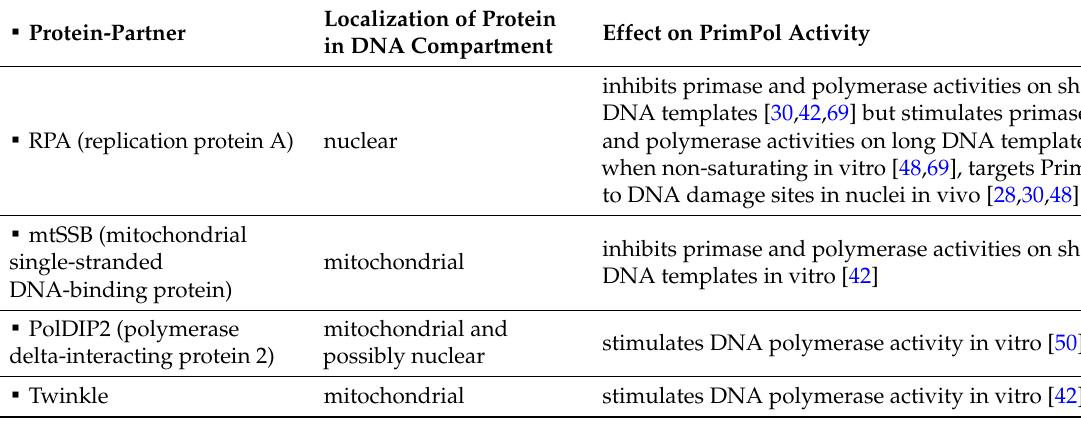
Table 2. Proteins interacting with PrimPol.